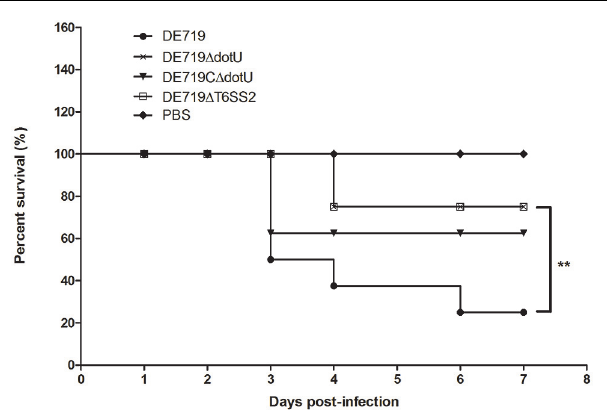
FIGURE 6 | Determination of bacterial virulence. 7-day-old ducks were inoculated intratracheally with DE719, DE719 (cid:2) dotU, DE719C (cid:2) dotU, or DE719 (cid:2) T6SS2 suspensions at 10 7 colony-forming units (CFUs). Negative controls were injected with PBS. Survival was monitored until 7 days post-infection. ** p < 0.01, compared with DE719.